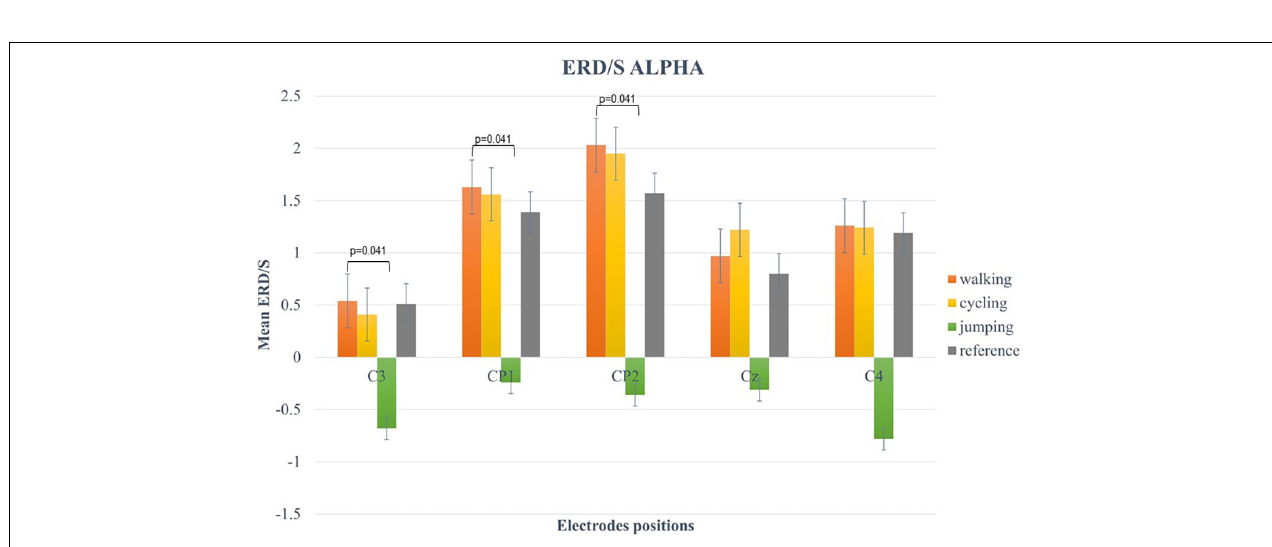
FIGURE 3 | Topographical 2D scalp maps of the alpha (A) and beta frequency (B) bands for all four conditions. The maps were generated on the averaged event-related spectral perturbations of the 32 electrodes in the time window of 8.5–11 s (MI task period).